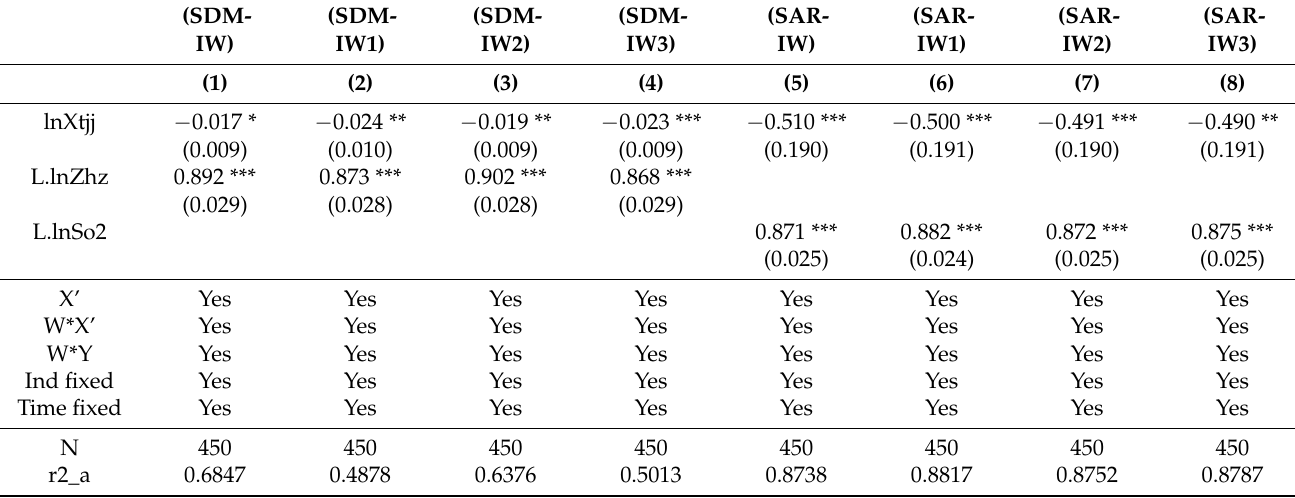
Table 6. The empirical results of robust